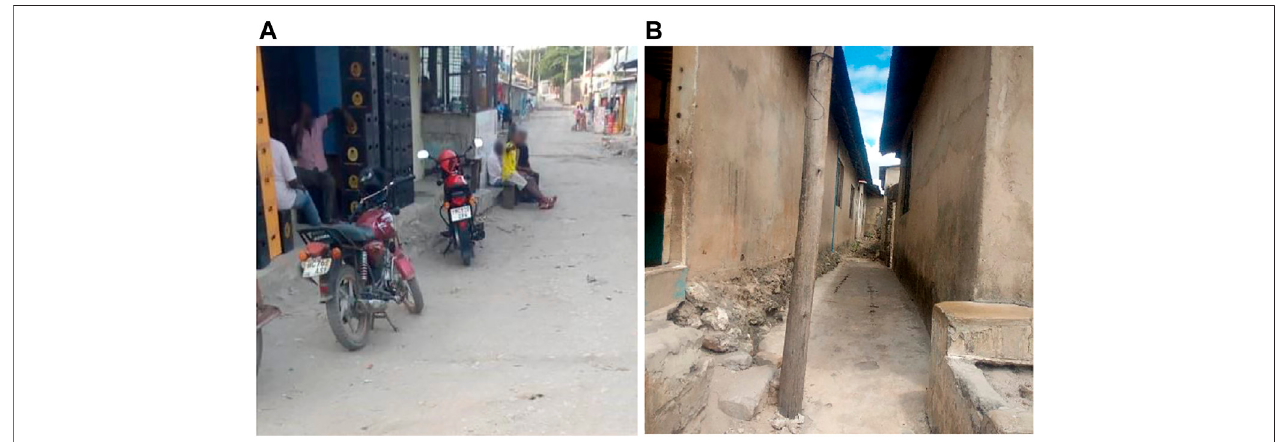
FIGURE6| Longstretchofstreetwithjustonetree (A) .Stretchofhouseswithouttrees/greeneryinbetween (B) .PicturestakenbyOlumuyiwaAdegun,September 2019.